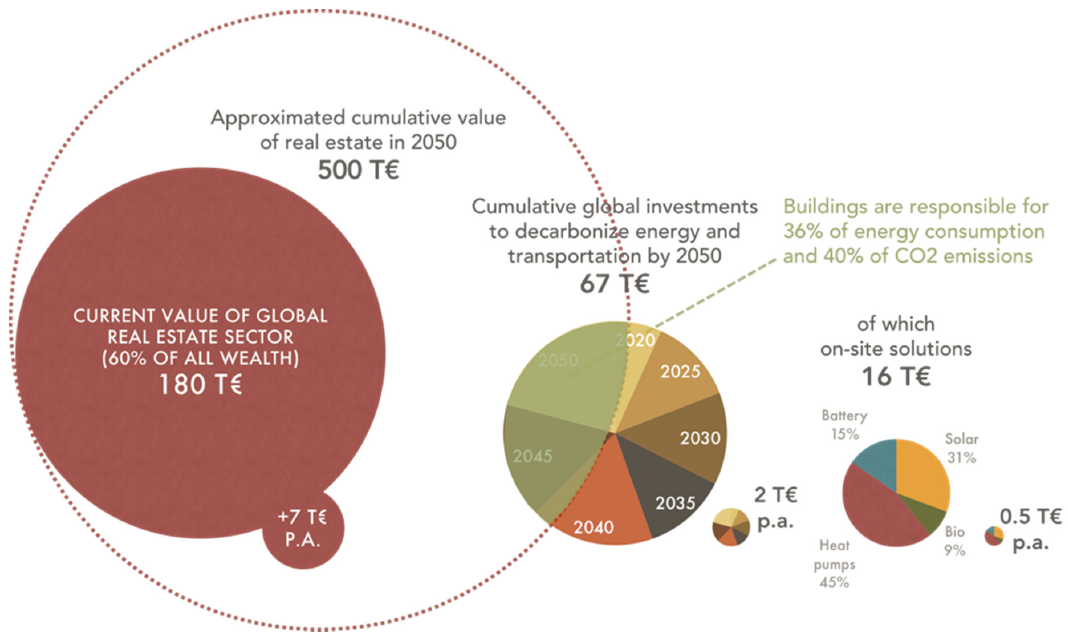
Figure 1. Economic size of the real estate sector in comparison to investments required for a 100% renewable energy system. Data for real estate value are from [6], annual investments into buildings are from [7] and energy investment data are from [1]. The approximation of the cumulative value of real estate is based on estimations [8] of building stock in 2050 and the current and near future investments into construction. Buildings energy consumption and emissions data are from [9].